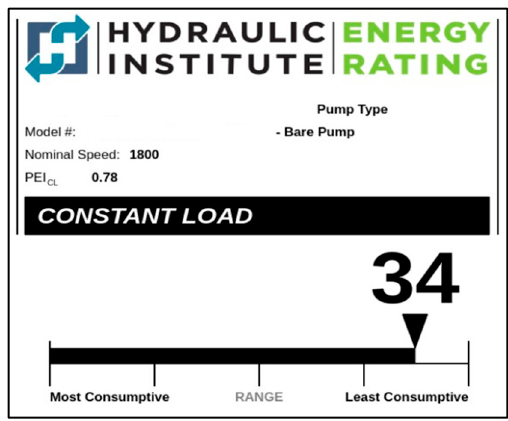
Figure 7. Example of USA Hydraulic Institute Energy Rating label for pumps.